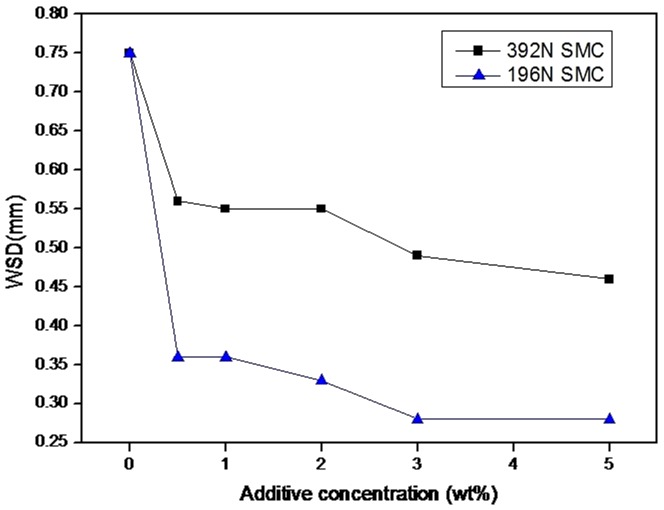
Wear scar diameter of additives.